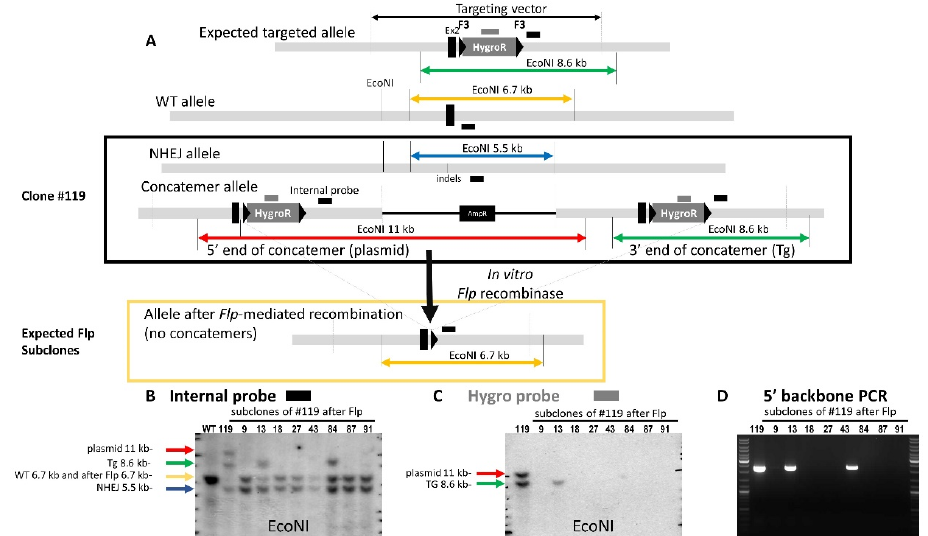
Figure 4. Evidence that concatemers occur at the locus. ( A ) Schematic drawing of the expected targeted, WT and clone #119 alleles (surrounded by a black rectangle). If concatemers at the locus occur, the action of the Flp recombinase, when optimal, should remove all the additional copies and leave only one F3 site. In order to visualize the allele (as the Hygro probe could no longer be used), targeting construct (in the 3 (cid:48) homology arm). ( B ) Southern blot with an internal probe that